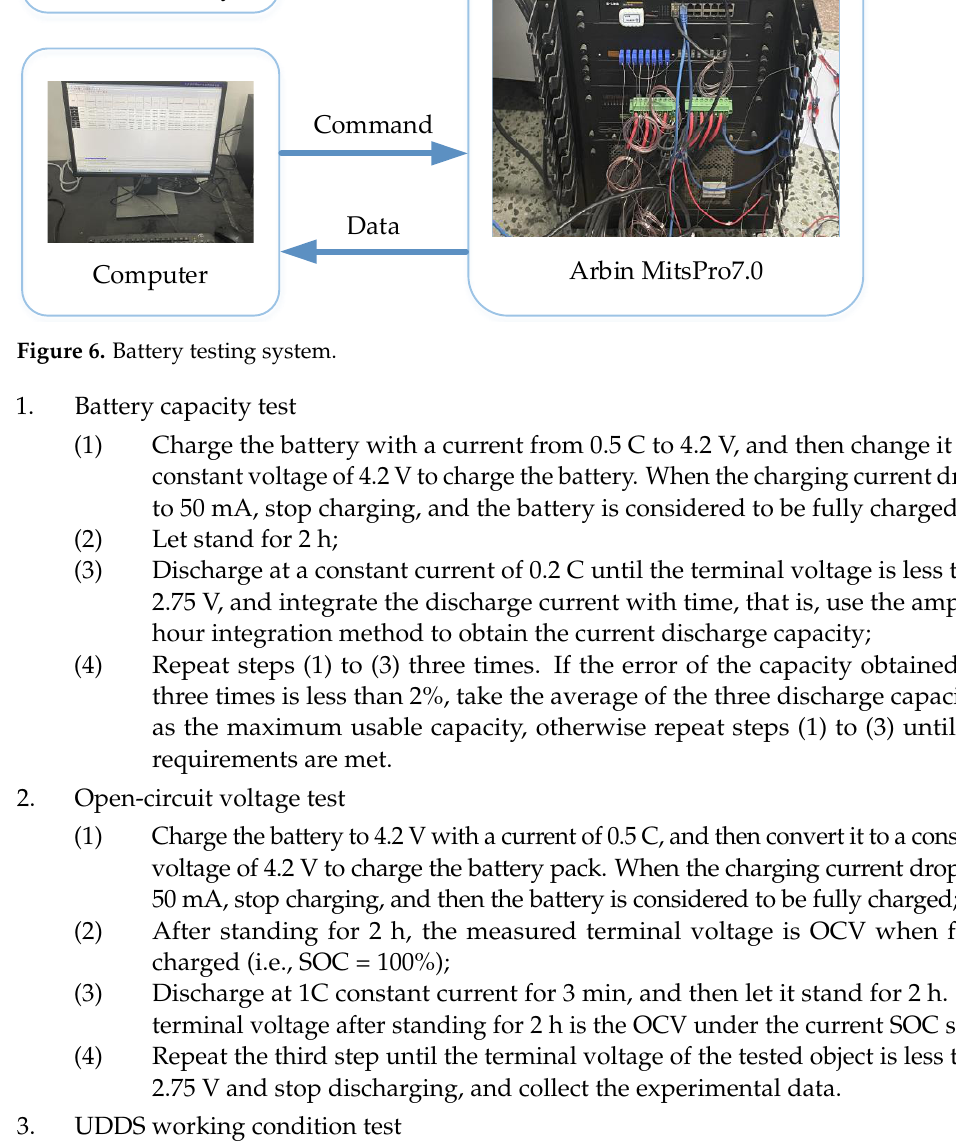
==  Figure 5. SOP estimation process. 4. Validations and Discussion